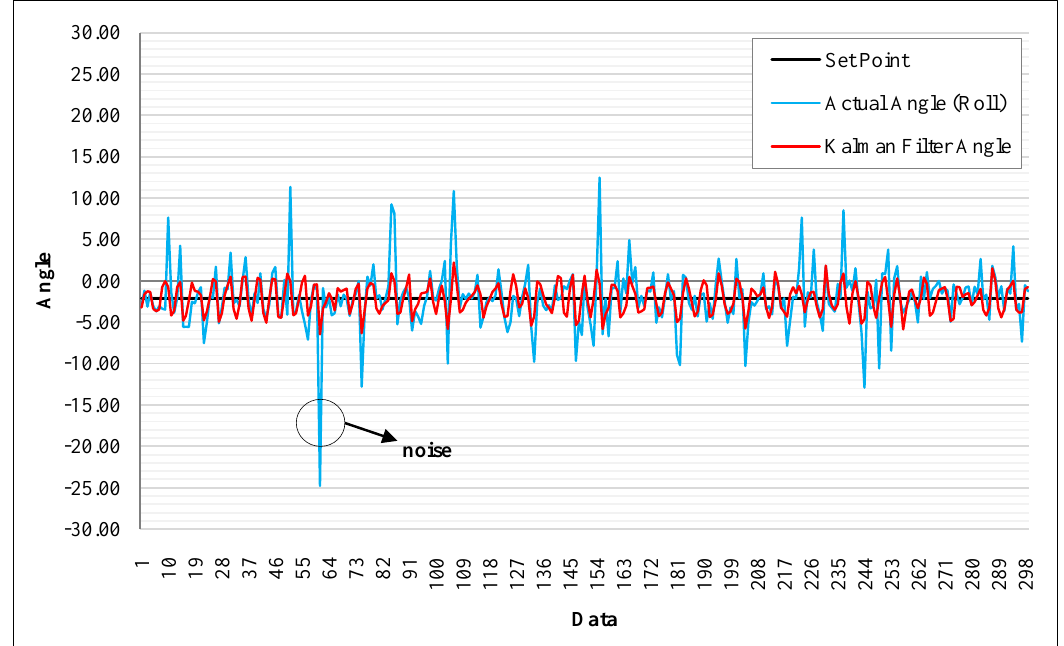
Figure 17. Comparison of angle reading values with